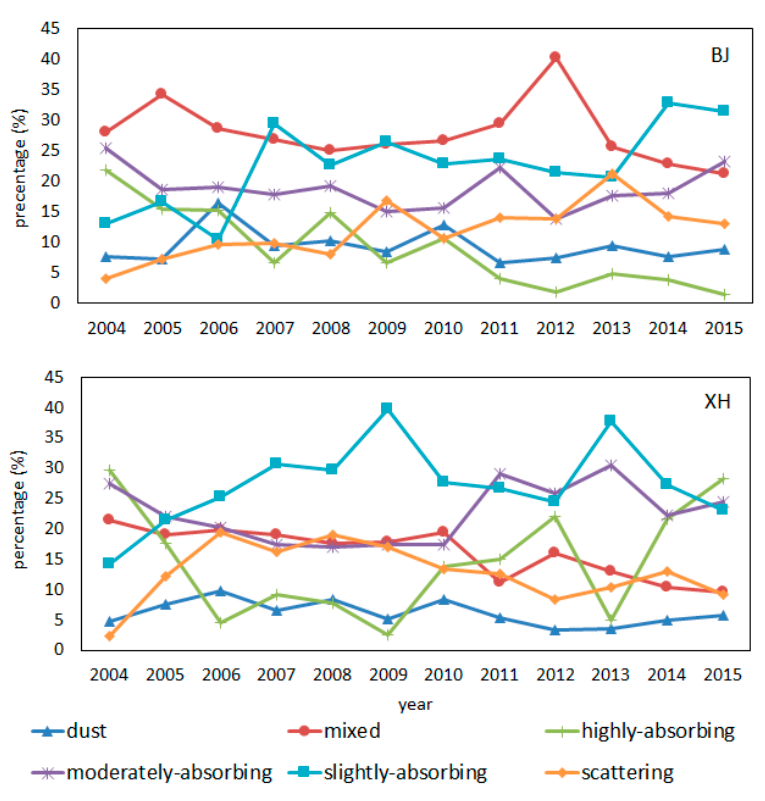
Figure 8. A time series of the aerosol types in BJ and XH stations in the past 12 years.